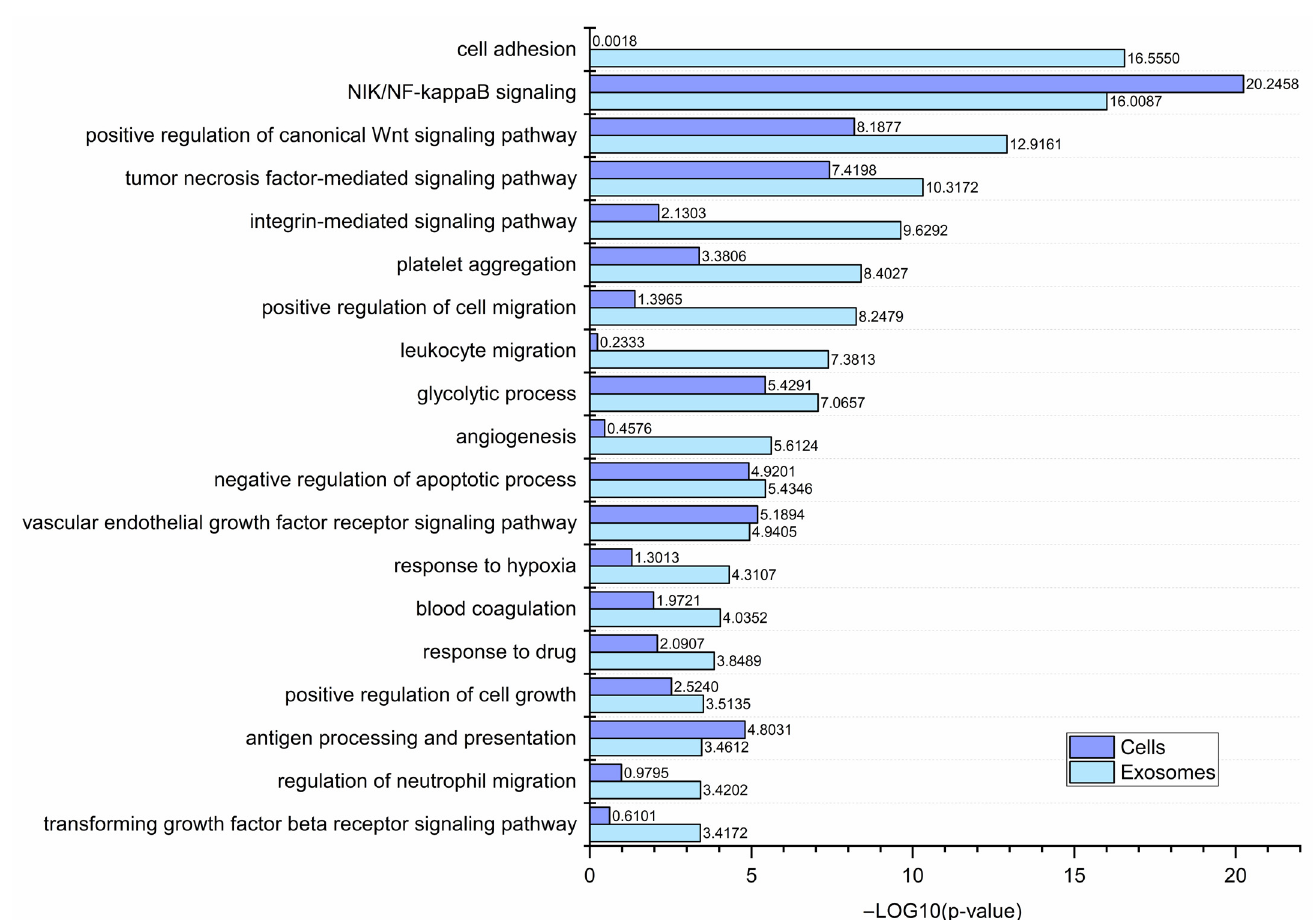
Figure 8. Gene ontology annotations by the biological process of all proteins identified in CM cells (3514 proteins) or CM-derived exosomes (1234 proteins) performed via the UniProt (release 2022_11) database. Enrichment significance scores (i.e., − log10( p -value)) within the chosen cancer-related categories for CM cells or CM-derived exosomes are presented in the graph. WM115/WM266-4,WM793/WM1205Lu—isogenic pairs (primary/metastatic) of CM cell lines that were used for LC-MS/MS analysis and exosome isolation. Complete results are presented in Supplementary Data S2.